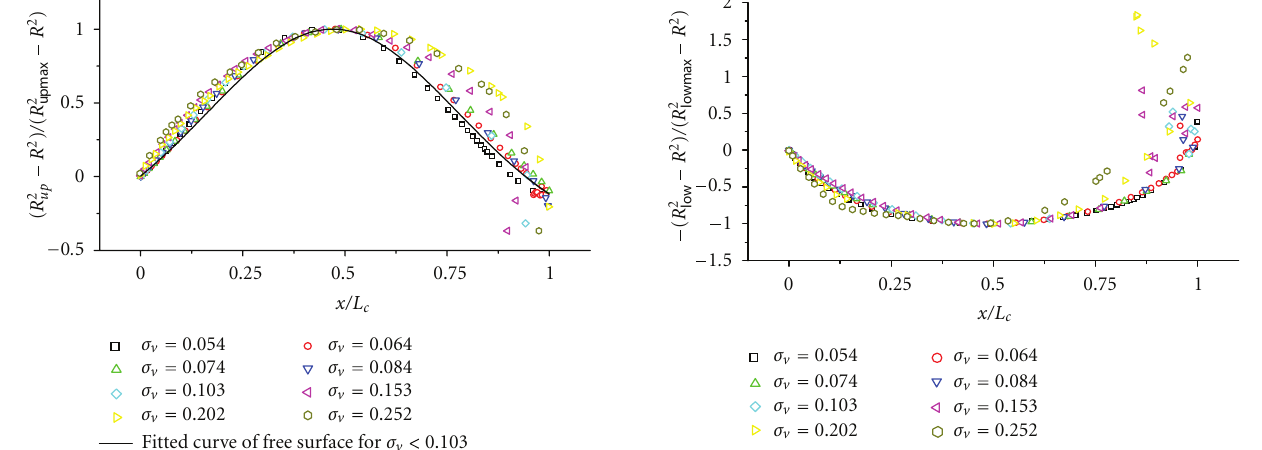
Figure 10: Universal profiles of the lower surface of the cavity at di ff erent σ v , h/H = 0 . 25.